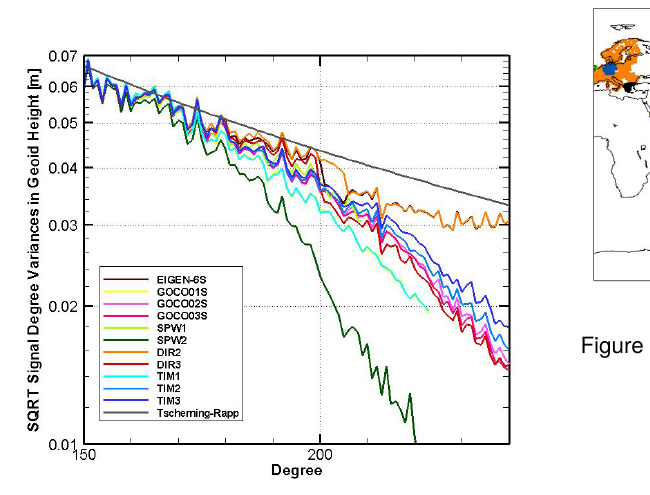
Figure 2. Square root of signal degree variances in terms of geoid heights for GOCE based satellite-only models between de- gree 150 and 240.